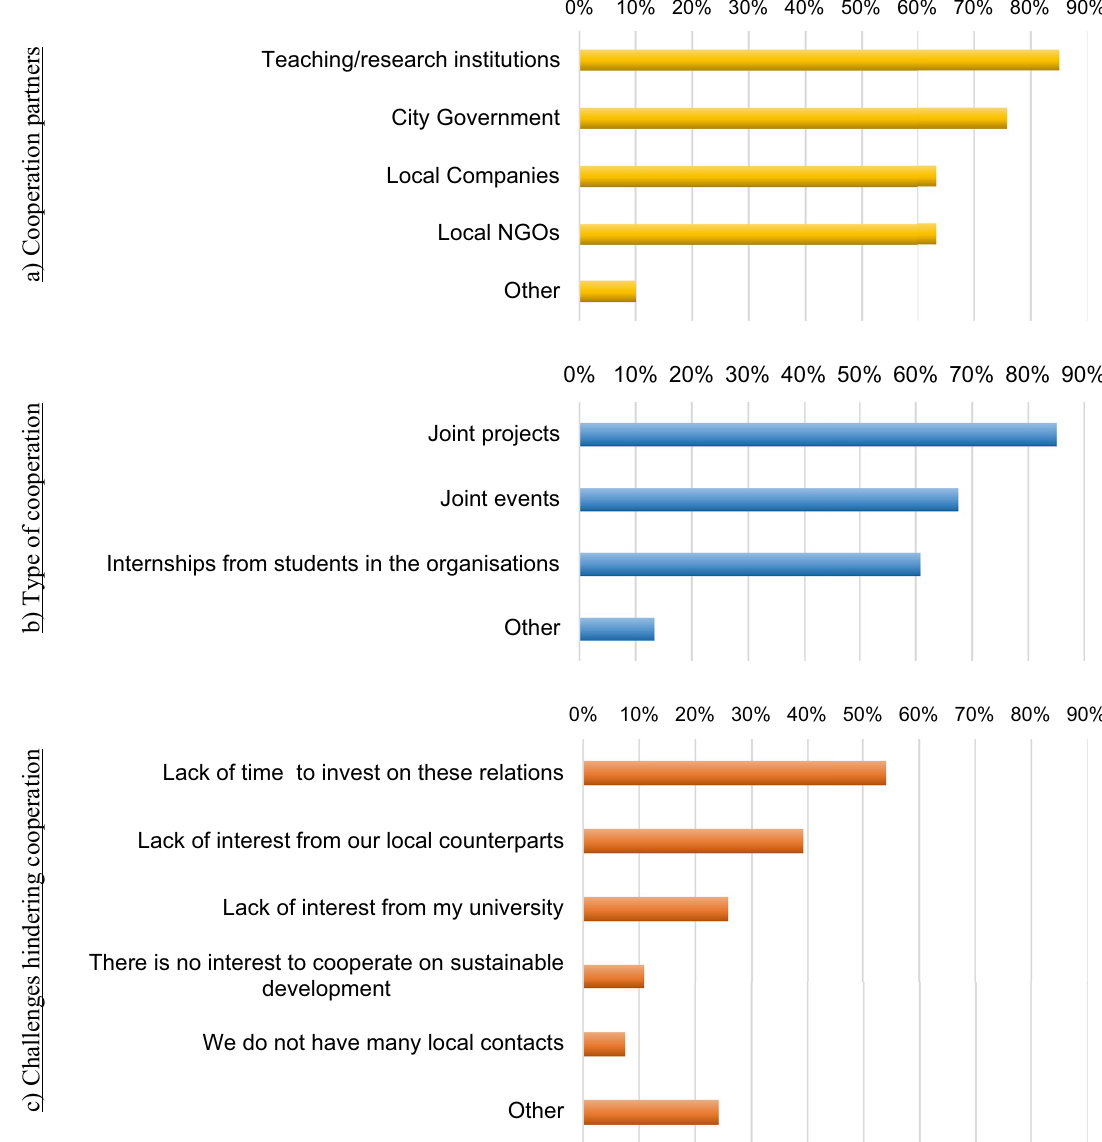
Figure 3. Cooperation partners, type of cooperation, and hallenges hindering cooperation ( Source prepared by the